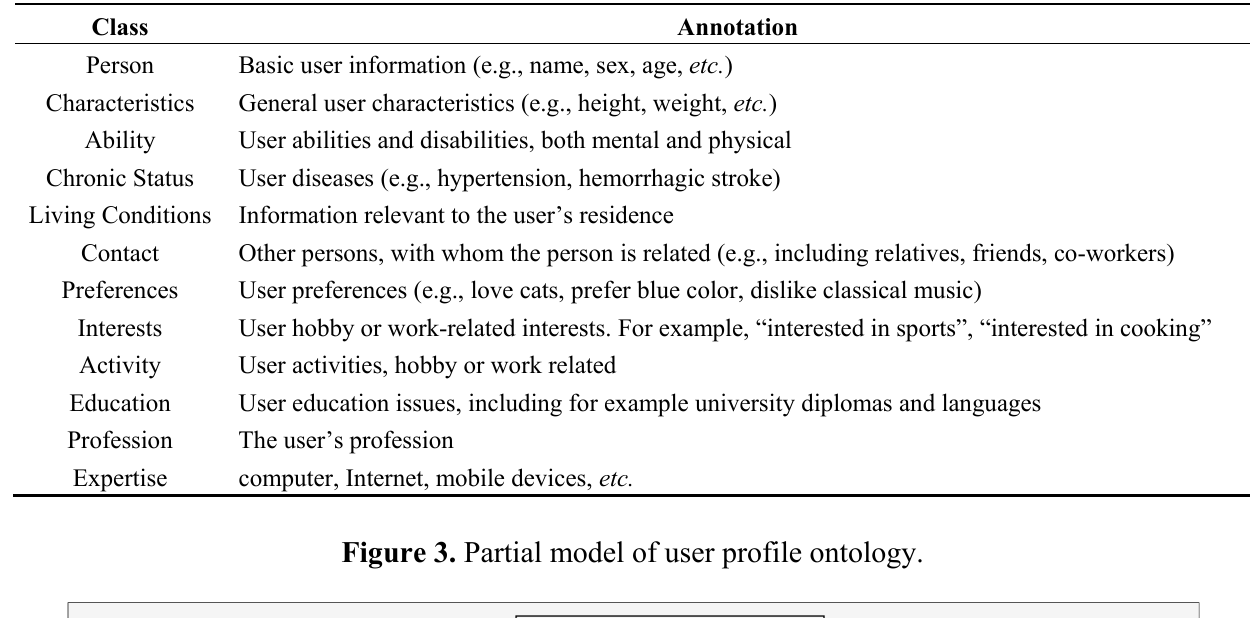
Table 1. Ontology classes of a personal profile.